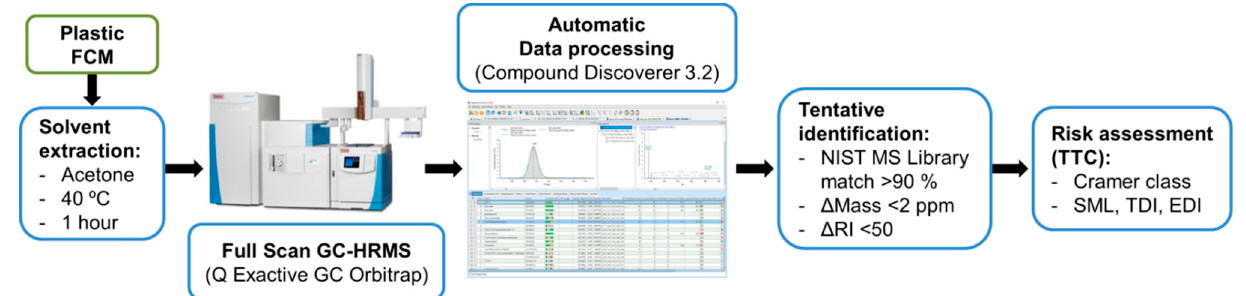
Figure 1. Scheme of the overall analytical methodology.